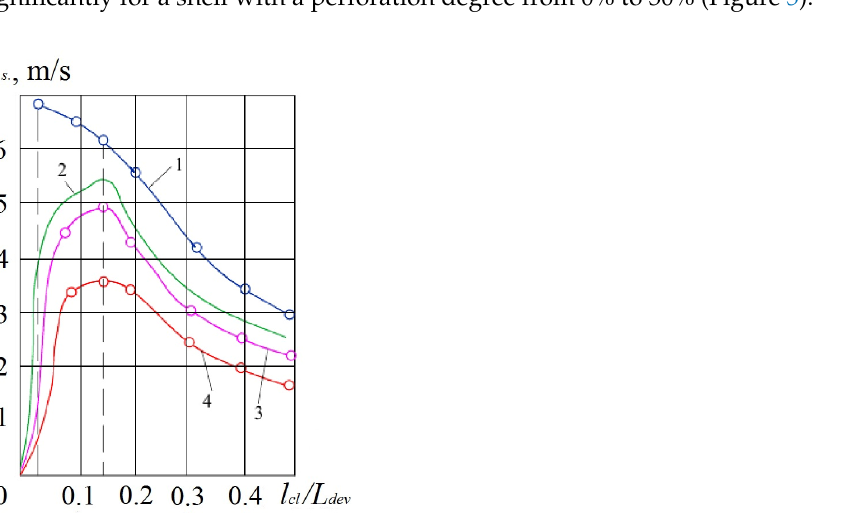
Figure 5. The dependence of the gas flow velocity in the outloading space on the constructive parameters of the shelf. Shelf perforation degree ψ : 1–4—respectively, 0%, 5%, 15%, 30%. The tilt angle of the shelf— γ = 25°. Gas flow velocity in the free cross-section—1.65 m/s.